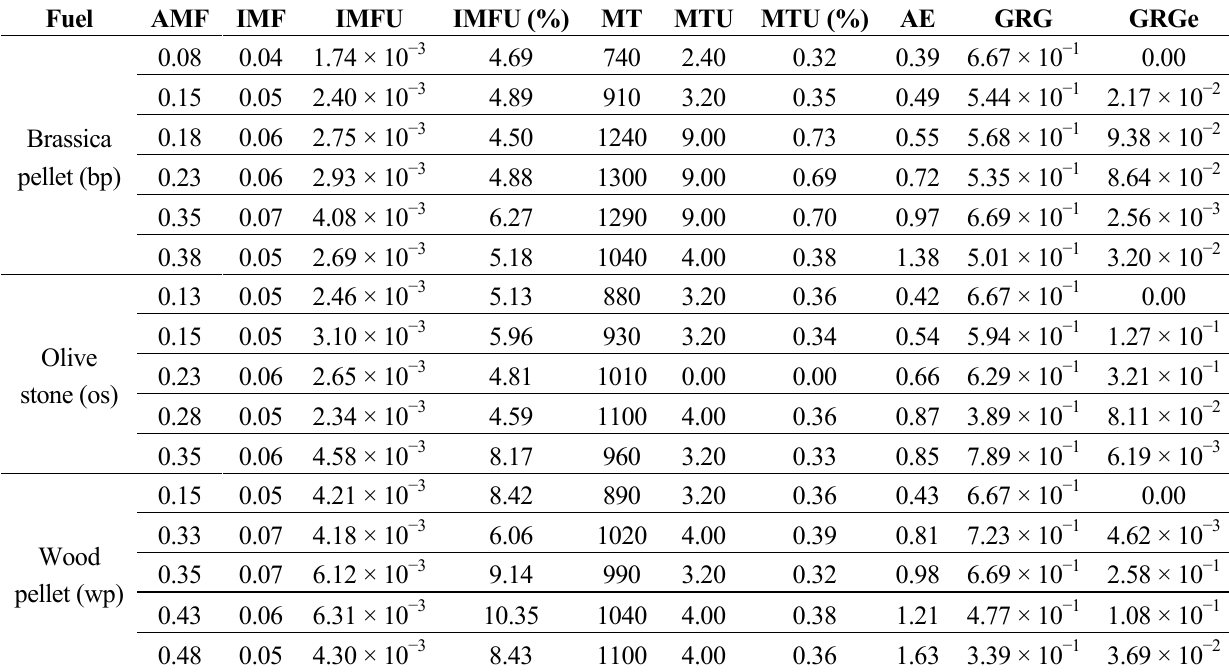
Table 3. Experimental results, grey relational grade (GRG), and grey relational grade error (GRGe). AMF: Air mass flow (kg m −2 s −1 ); IMF: Ignition mass flux (kg m −2 s −1 );